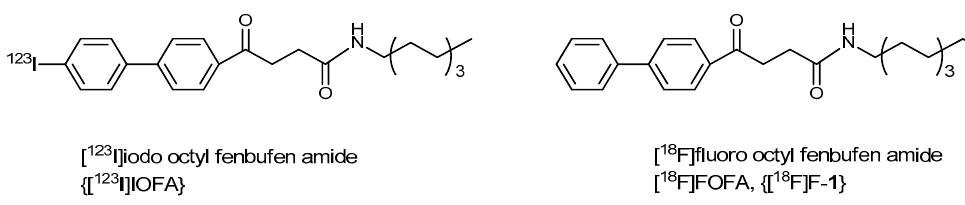
Figure 1. NSAIDs analogue derived radiotracers [ 123 I]IOFA and [ 18 F]FOFA {[ 18 F]F- 1 } studied for SPECT (previous study) and PET imaging (this study) of tumors, respectively.